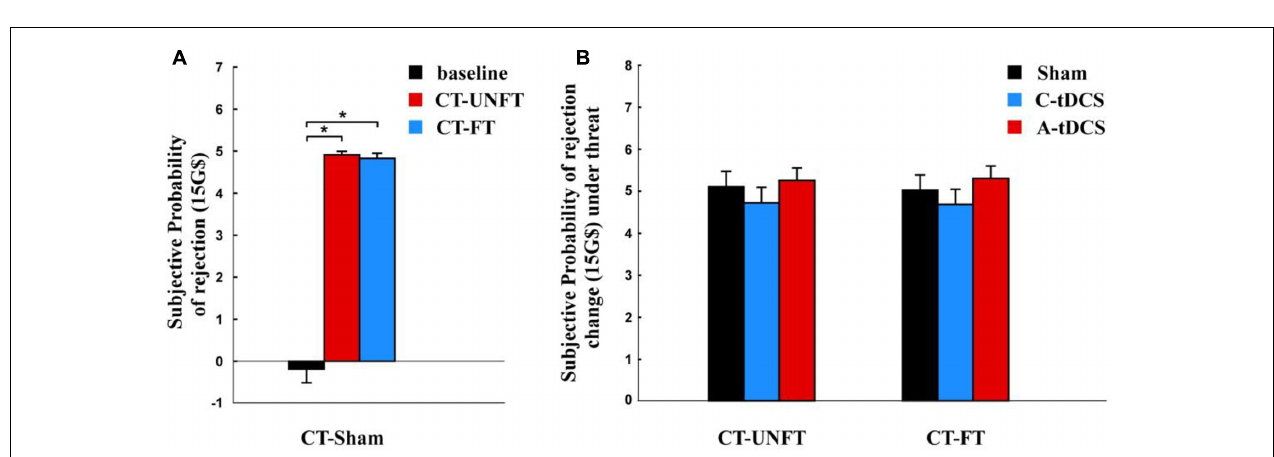
FIGURE 5 | Subjective probability change of rejection after credible threat. (A) Mean subjective probability of rejection and the standard error in the sham group. (B) Effects of tDCS and fairness on subjective probability change of rejection and the standard error in the cathodal (C-tDCS), anodal (A-tDCS), and sham stimulation group at each fairness level. The interaction was not significant between fairness and stimulation. ∗ p <